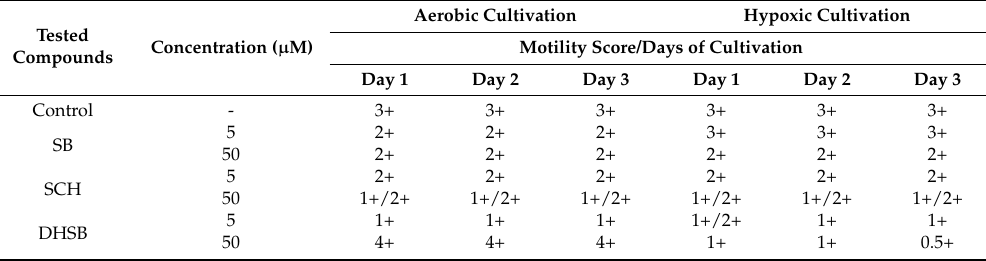
Table 1. Effect of flavonolignans on motility of larvae expressed as motility score. The intensity and mode of larval movement was evaluated over three days of cultivation under aerobic and hypoxic conditions under an inverted microscope. Normal motility is seen at 37 °C as moderate contractions of larval bodies in the anterior-posterior or dorsal-ventral directions.